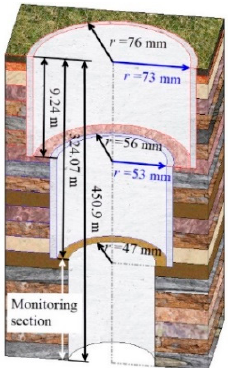
Figure 3. Diagram of the drilling structure.